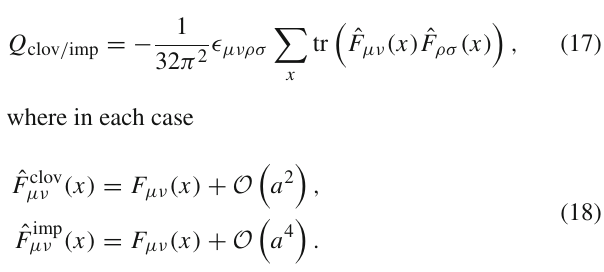
for the topological charge than for the action. We see